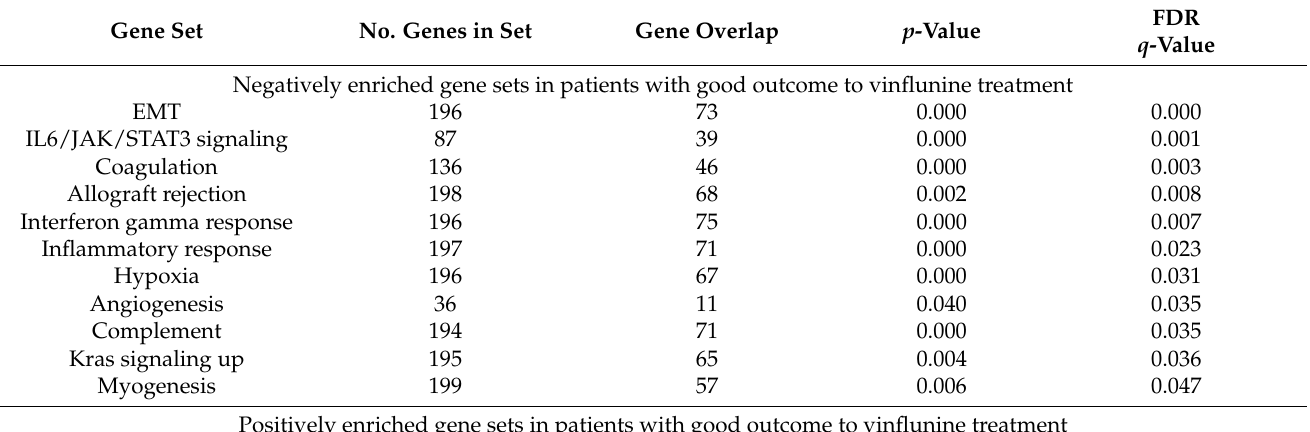
Table 3. Table showing the significant Hallmark terms negatively and positively enriched in patients with good outcome compared to those with poor outcome to vinflunine treatment, obtained by GSEA overlap.